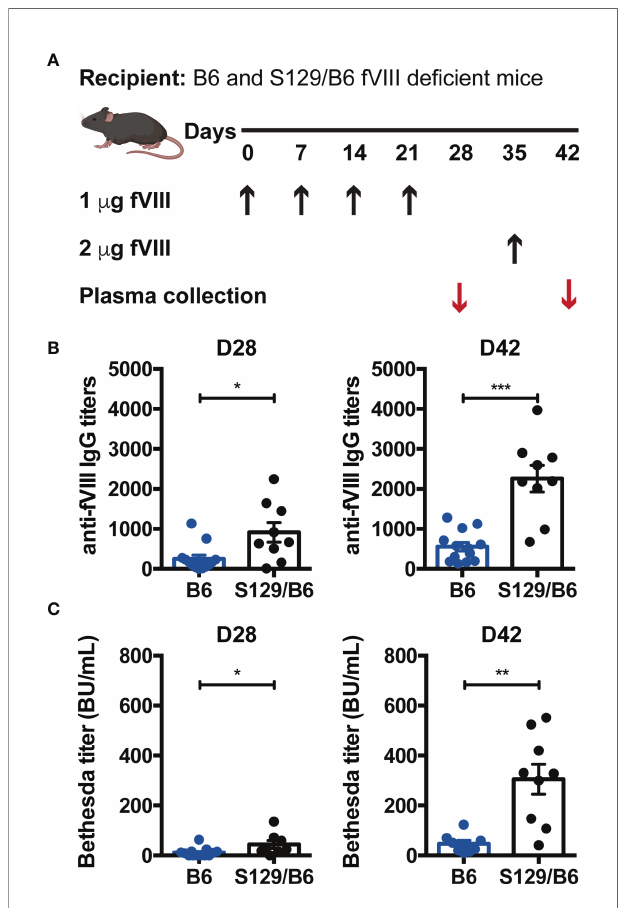
FIGURE 1 | FVIII de fi cient mice on a B6 background generate lower anti-FVIII IgG and inhibitor titers than those on an S129/B6 background. (A) Experimental schematic of FVIII immunization. B6 and S129/B6 FVIII de fi cient mice were administered 4 weekly infusions of 1 m g FVIII, followed by a 2 m g challenge. Plasma was collected pre (day 28; D28) and post (day 42; D42) challenge, and evaluated for production of anti-FVIII IgG (B) as well as inhibitors (C) by ELISA and Bethesda assay, respectively. Error bars represent ± SEM. Statistics were generated using an unpaired Mann-Whitney test. There were 8-13 mice per group. Data shown are the combined results from 2 experiments. *p < 0.05, **p < 0.01, and ***p <